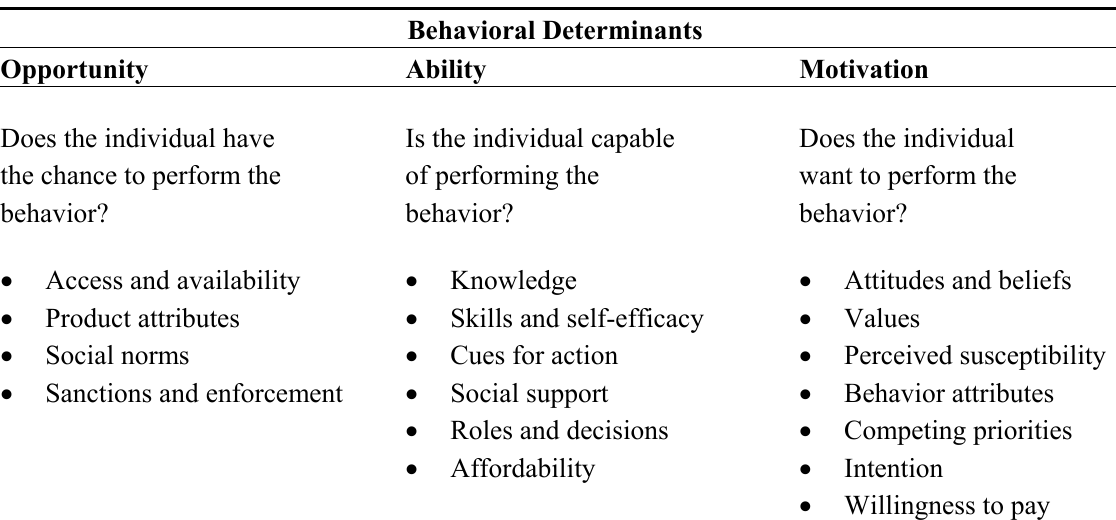
Table 1. Description of the opportunity, ability, and motivation behavior change framework (reprinted from [27] with permission from Jacqueline